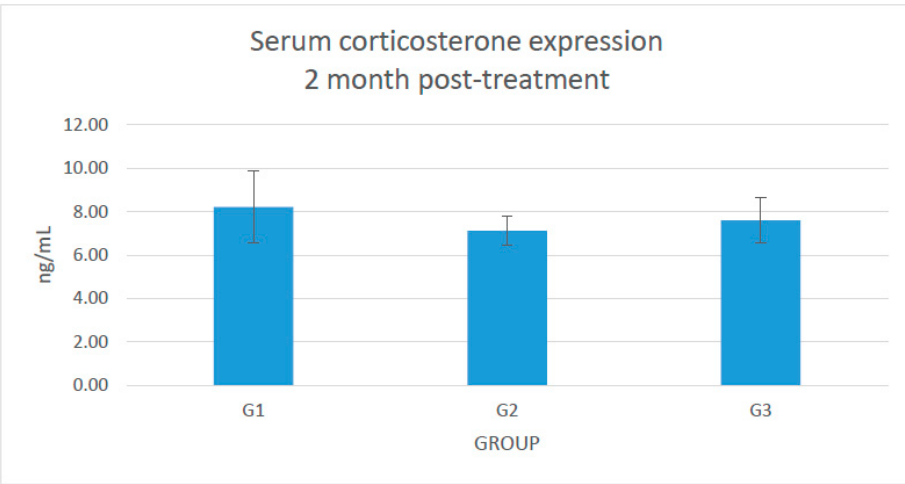
Figure 1. The effect of serum corticosterone expression in G1: sham-operated control; G2: adrenalectomized (adrx) control given intramuscular dexamethasone (DEX) 120 μ g/kg/day; and G3: adrx and given intramuscular DEX 120 μ g/kg/day and Piper sarmentosum 125 mg/kg/day.